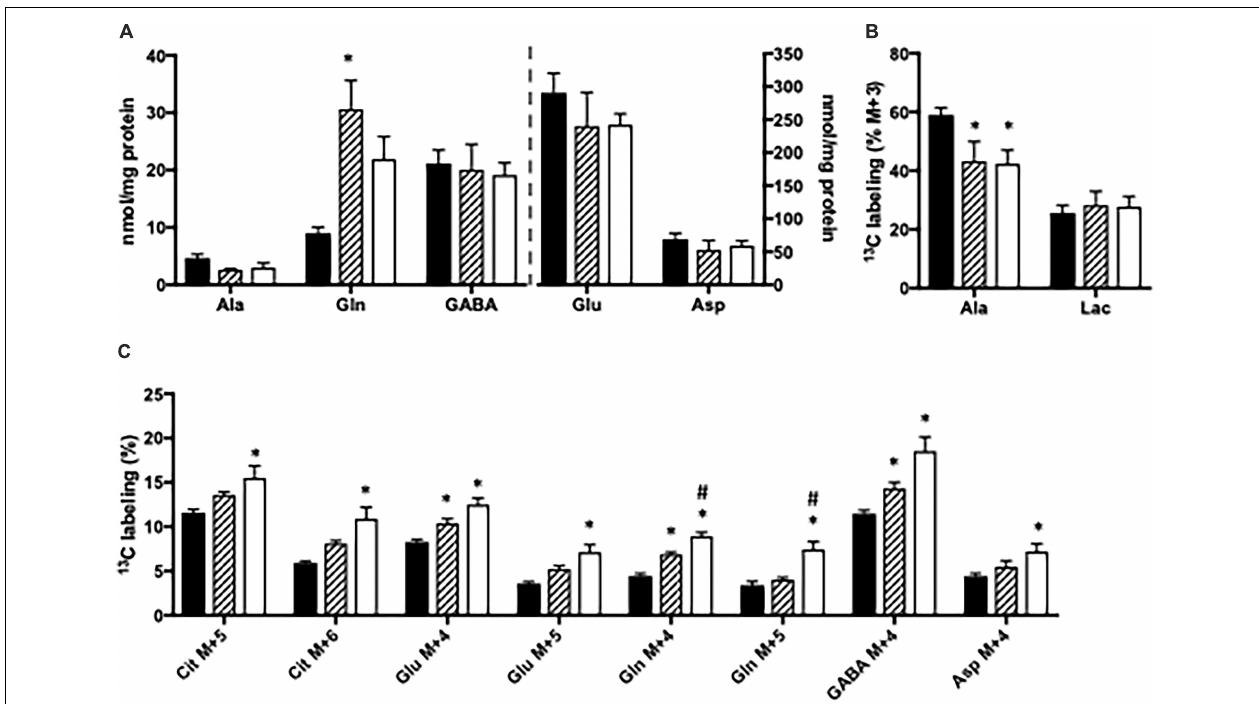
FIGURE 4 | Hippocampal slices from CNS- Glud1 − / − mice were incubated in medium containing 5 mM [U- 13 C]glucose and 0 mM (control; filled bars), 1 mM (hatched bars), or 5 mM (open bars) NH 4 Cl. The effect of ammonia treatment on the amounts (nmol/mg protein) of alanine, glutamine, GABA, glutamate, and aspartate (A) and the percent 13 C labeling originating from [U- 13 C]glucose in alanine M + 3 and lactate M + 3 (B) and in citrate M + 5, citrate M + 6, glutamate M + 4, glutamate M + 5, glutamine M + 4, glutamine M + 5, GABA M + 4, and aspartate M + 4 (C) . The hippocampal slices from CNS- Glud1 − / − mice were incubated in the presence of [U- 13 C]glucose for 60 min as detailed in Materials and methods. The amounts of metabolites were determined employing HPLC while the percent enrichment was determined from GC-MS analysis of slice extracts as detailed in Materials and methods. Results are averages ± SEM ( n = 6–10), and the asterisk indicates a statistically significant difference from hippocampal slices from CNS- Glud1 − / − mice incubated in the absence and presence of 1 or 5 mM NH 4 Cl while a number sign indicates a statistically significant difference between hippocampal slices from CNS- Glud1 − / − mice incubated in 1 and 5 mM NH 4 Cl ( P < 0.05). Ala, Alanine; Lac, Lactate; Cit, Citrate; Glu, Glutamate; Gln, Glutamine; GABA, γ -aminobutyric acid; Asp,